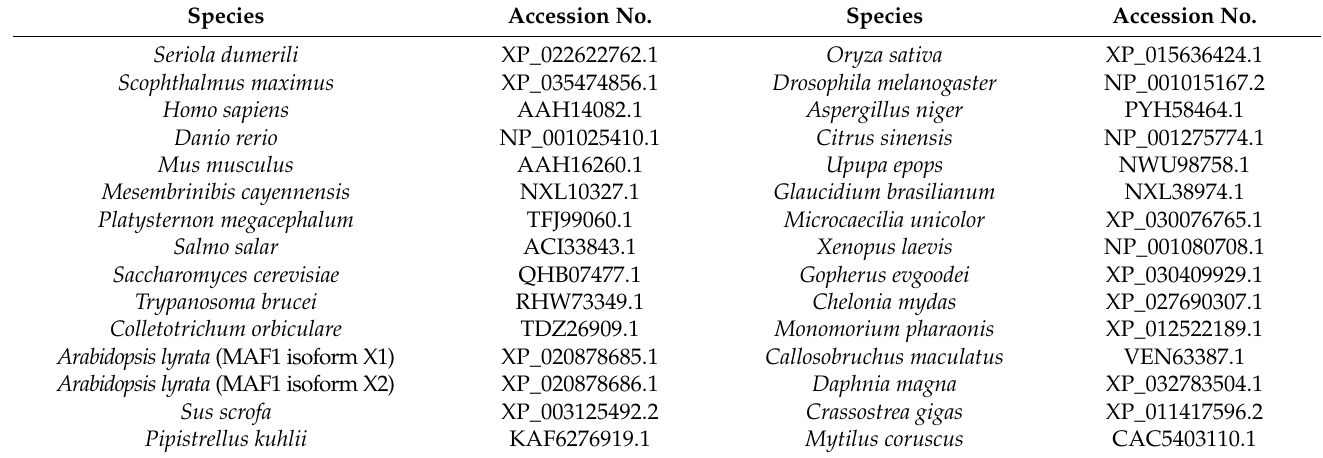
Table 1. GenBank accession numbers used for phylogenetic tree